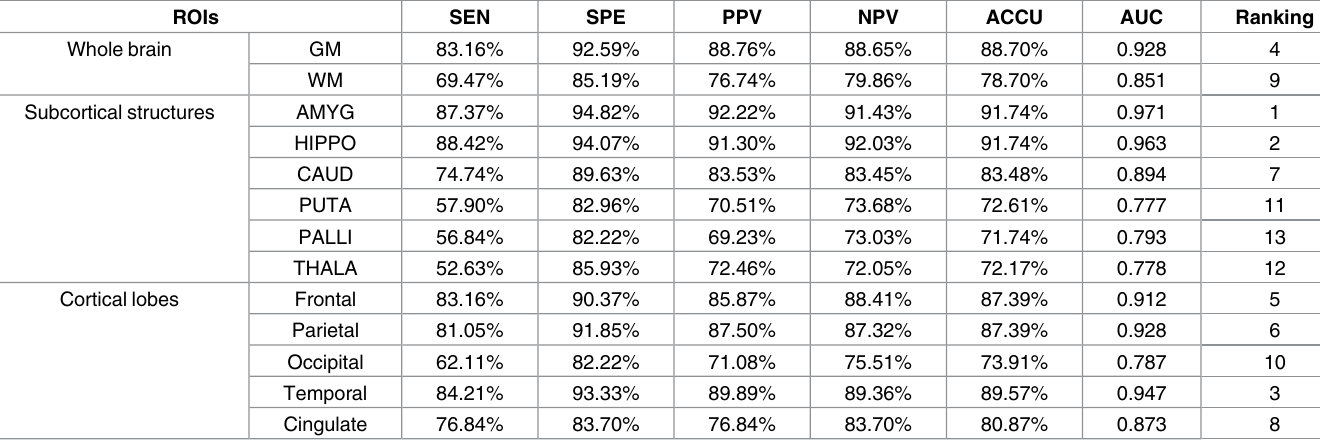
Table 3. Classification results of normal elderly controls vs pMCI.